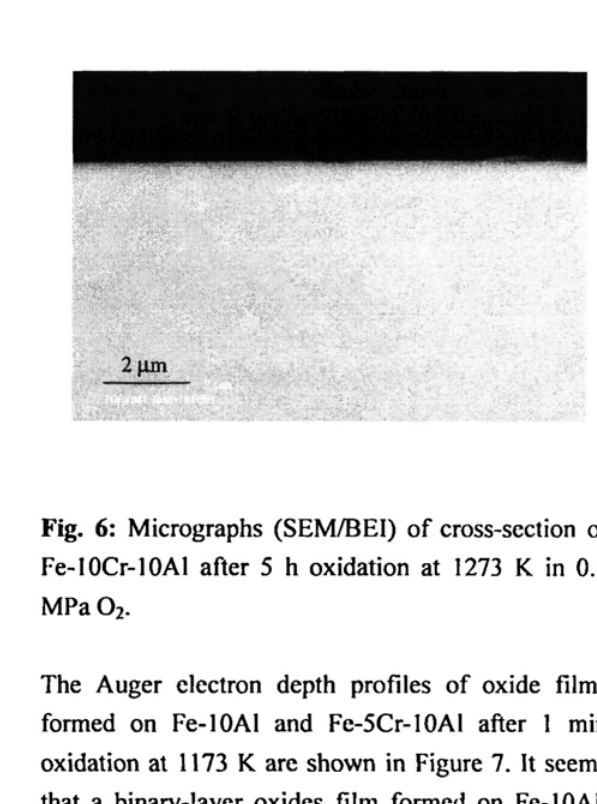
Fig. 6: Micrographs (SEM/BEI) of cross-section of Fe-IOCr-10Al after 5 h oxidation at 1273 K in 0.1 MPaO . 2